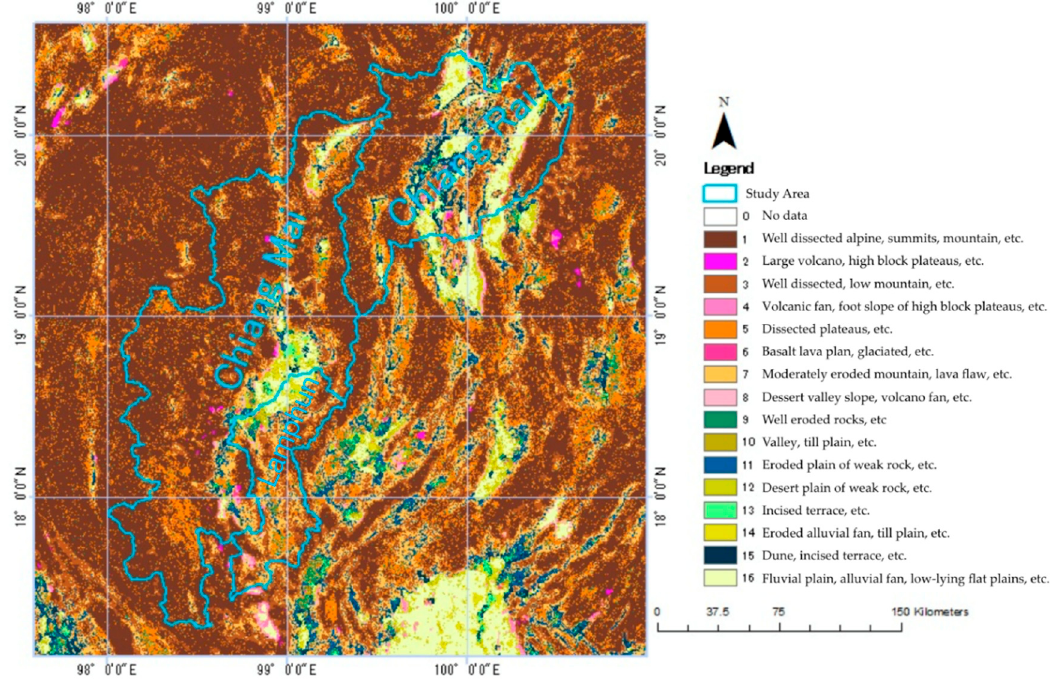
Figure 6. Geomorphology map for AOI2 obtained using a 250-m resolution DEM (Figure 2(ii)).